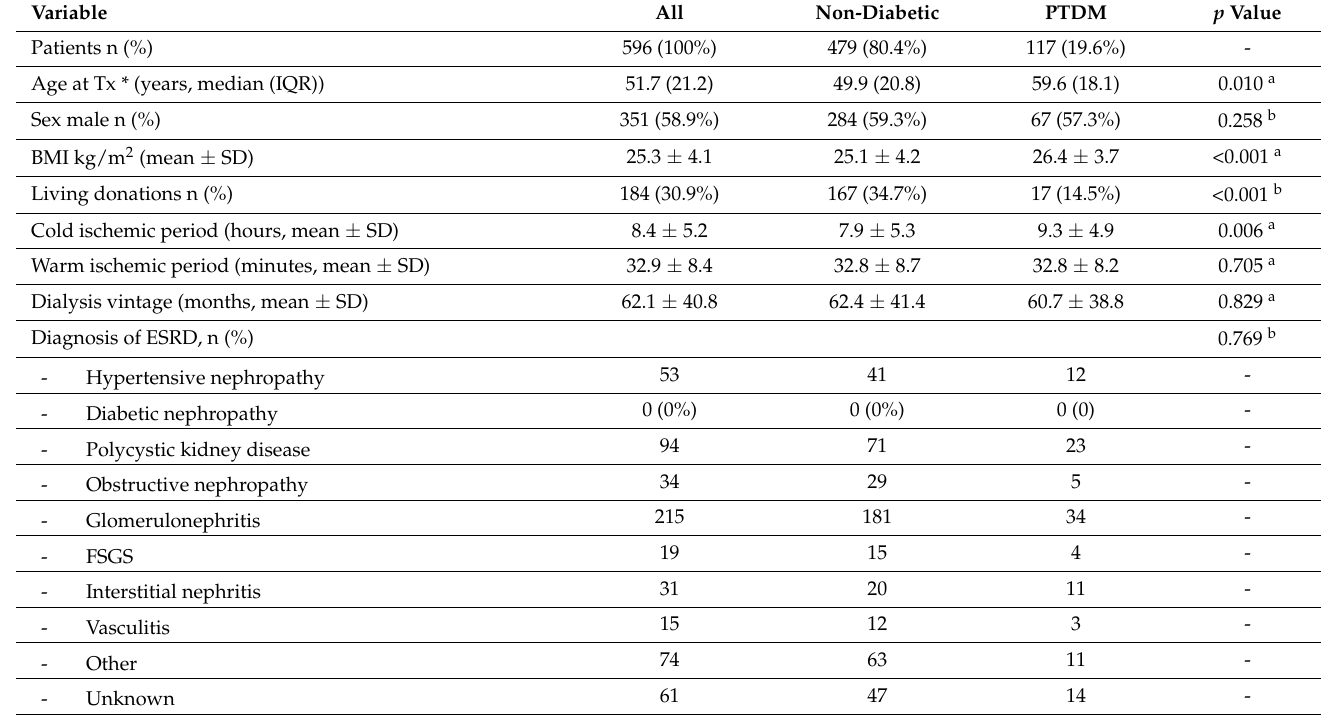
Table 1. Patients’ demographic and clinical characteristics at